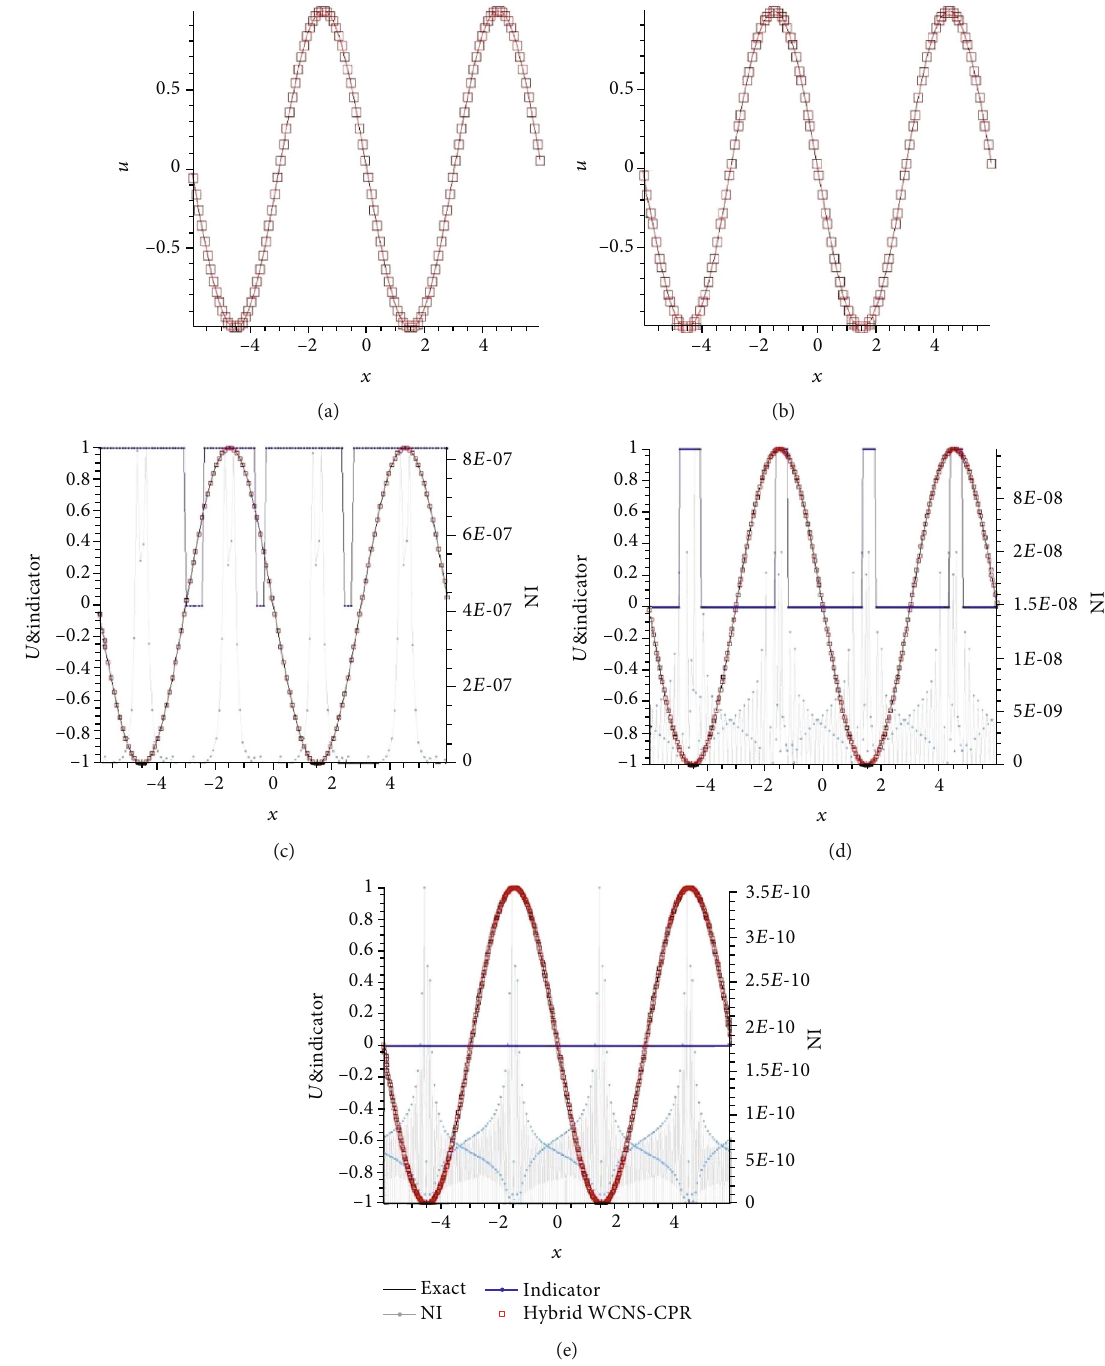
Figure 7: Numerical results of third-order single scheme and hybrid WCNS-CPR scheme. (a) WCNS in ½ − 6, 6 (cid:2) with DOFs = 120 . (b) CPR in ½ − 6, 6 (cid:2) with DOFs = 120 . (c) Hybrid WCNS-CPR scheme in ½ − 6, 6 (cid:2) with DOFs = 120 . (d) Hybrid WCNS-CPR scheme in ½ − 6, 6 (cid:2) with DOFs = 240 . (e) Hybrid WCNS-CPR scheme in ½ − 6, 6 (cid:2) with DOFs = 480